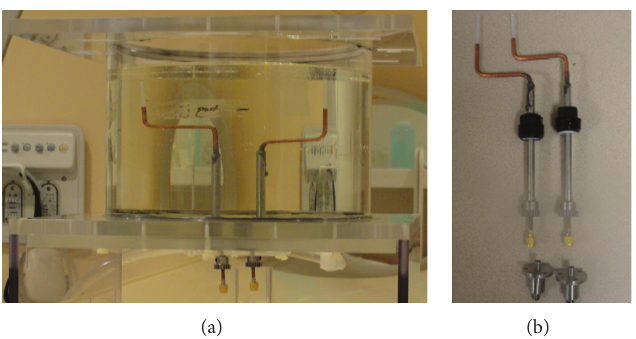
Figure 2: Photographs of (a) the new feed construct and antennas placed inside the imaging chamber and (b) the two bent monopoles inserted through their hydraulic seals prior to rotary joint